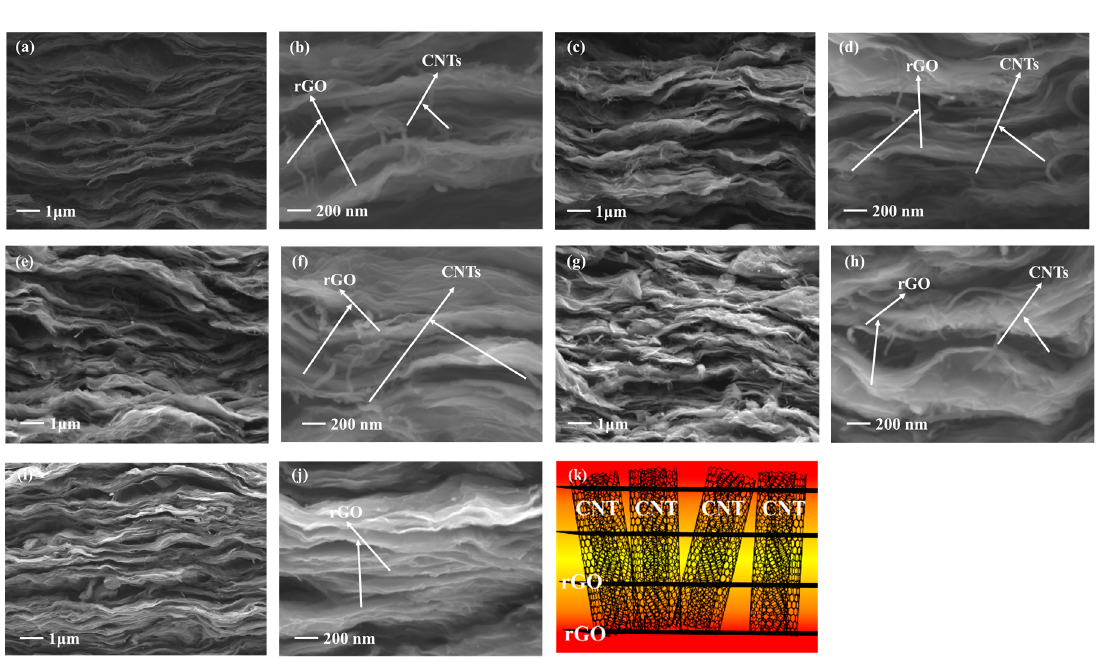
Figure 2. SEM cross-sectional images of the rGO/CNT composite films with different annealing temperatures: ( a ) Low magnification at 1400 °C, ( b ) high magnification at 1400 °C, ( c ) low magnification at 1300 °C, ( d ) high magnification at 1300 °C, ( e ) low magnification at 1200 °C, ( f ) high magnification at 1200 °C, ( g ) low magnification at 1100 °C and ( h ) high magnification at 1100 °C; SEM cross-sectional images of the rGO film after annealing at 1400 °C: ( i ) Low magnification and ( j ) high magnification; ( k ) schematic illustration of the rGO/CNT composite film.